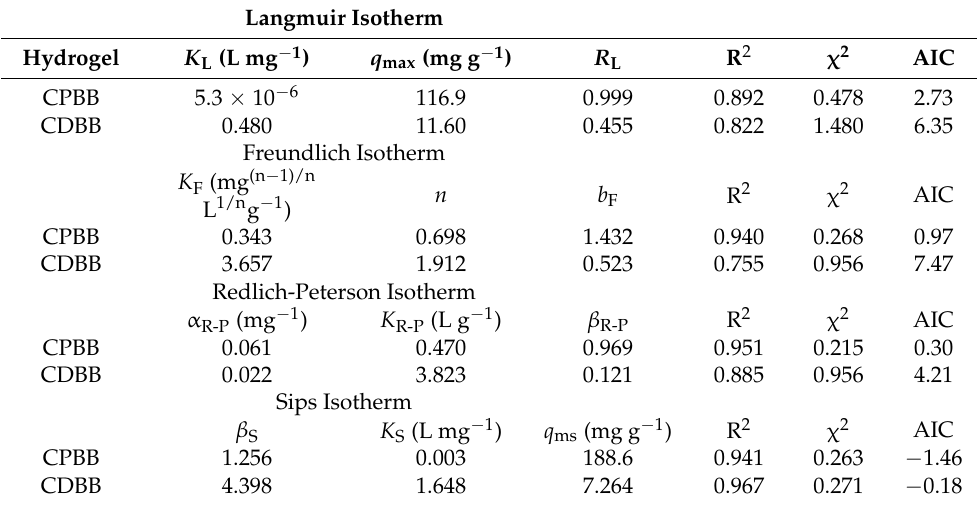
Table 3. Parameters of nonlinear Langmuir, Freundlich, Redlich–Peterson and Sips isotherm models for the adsorption of MB to the chitosan/pectin (CPB) and chitosan/DNA (CDB) blend hydrogels. Langmuir Isotherm